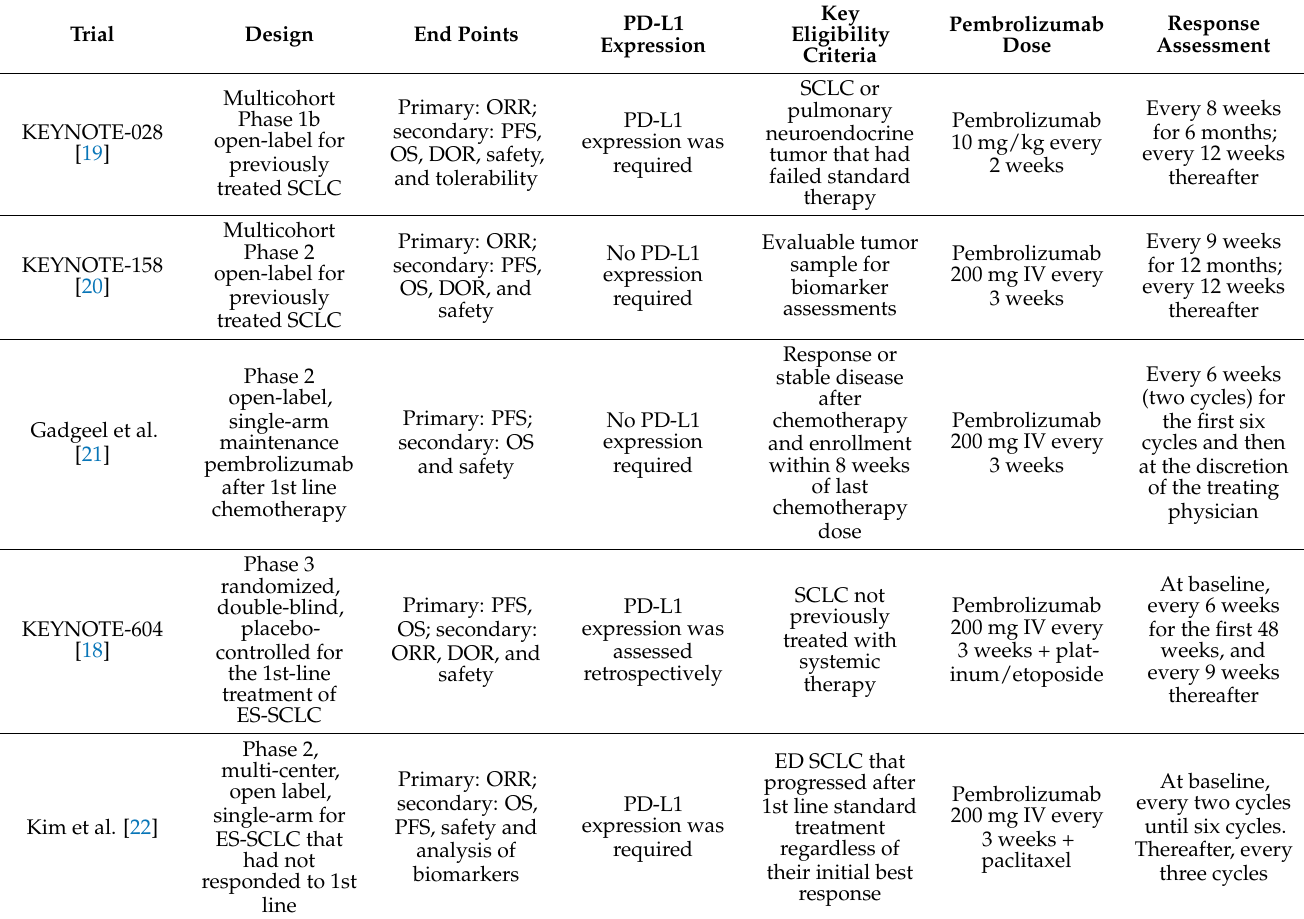
Table 1. Comparison between designs of published pembrolizumab clinical trials in extensive-stage small-cell lung cancer. Trial Design